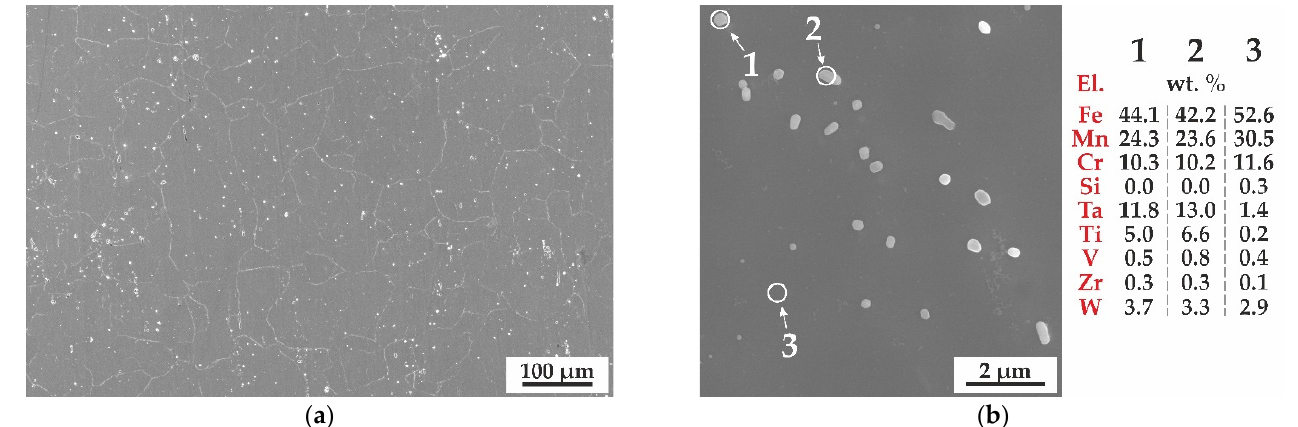
Figure 3. SEM SE (secondary electrons) overview image ( a ), magnified SEM SE image with ele- mental composition of some dispersed particles and matrix ( b ).